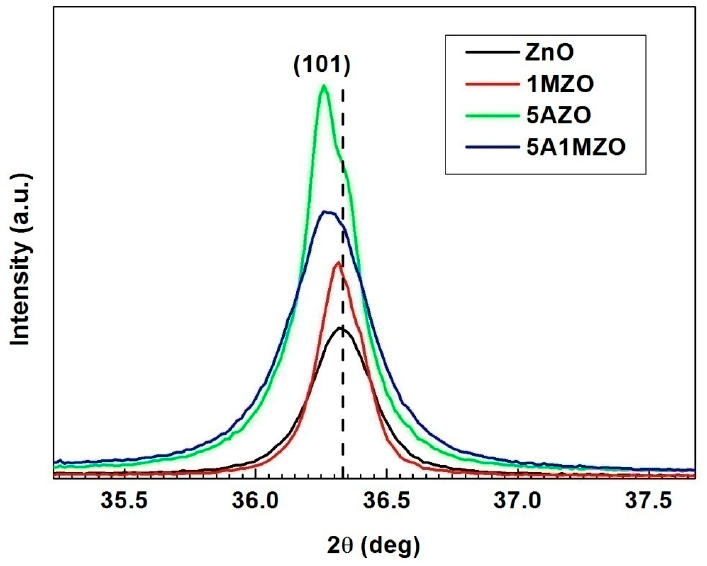
Figure 3. Shift of (101) peak of MZO, 5AZO and 5A1MZO from that of ZnO sample. The crystallite size was estimated using the Scherrer’s method [32] (Equation (2)) and the (101) plane was chosen for calculation.